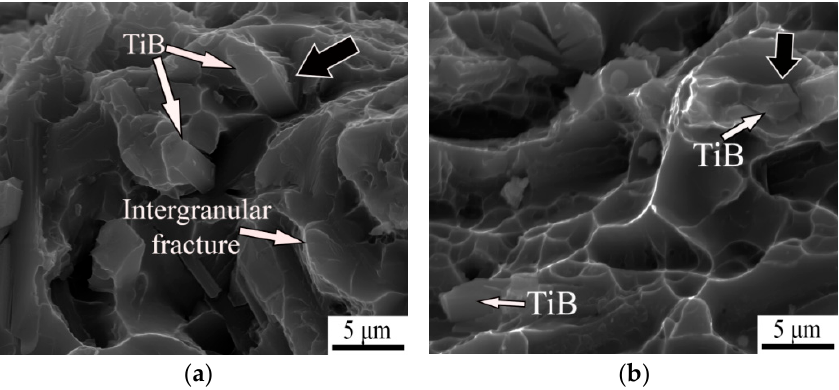
Figure 8. Fracture surfaces of tensile tested specimens at 500 °C ( a ) in as-sintered condition and ( b ) after hot rolling. Grooves around TiB particles are shown with black arrows.